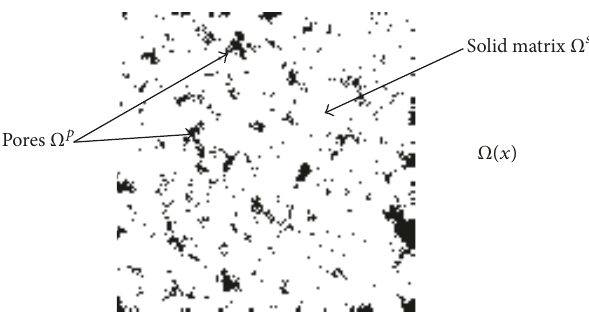
Figure 2: The real porous media constructed by the